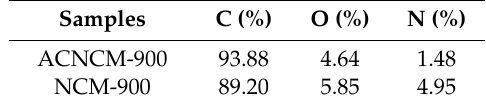
Table 1. XPS peak analysis of the carbon samples.